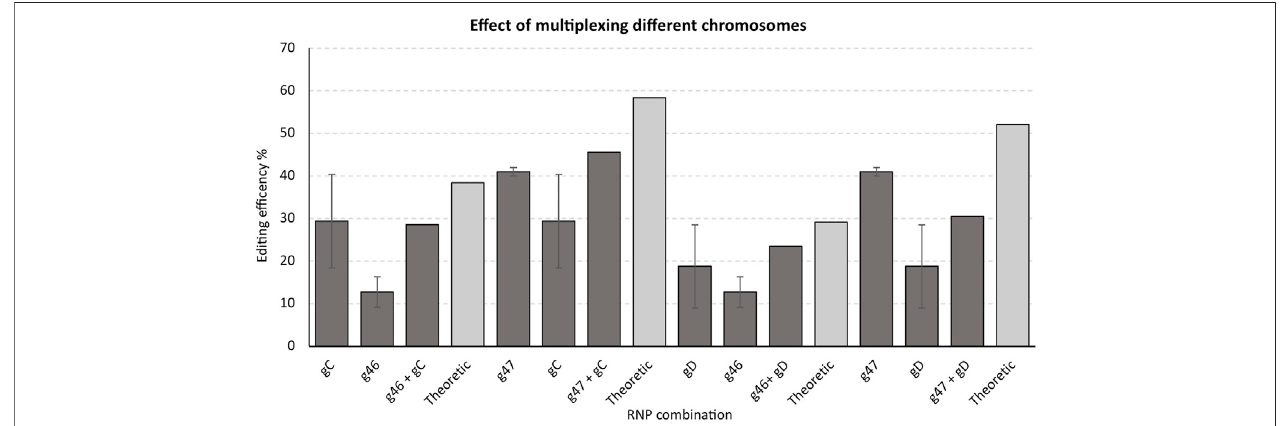
FIGURE 6 | Effect of editing when simultaneously targeting (multiplexing) the 3 ’ end of GWD1 and DMR6-1, residing on different chromosomes . Single RNPs/ gRNAstargetingthe3 ’ endofGWD1(chromosome5)andDMR6-1(chromosome3)wereselectedandemployedindividuallyorincombination.IDAAprimerpairsused: